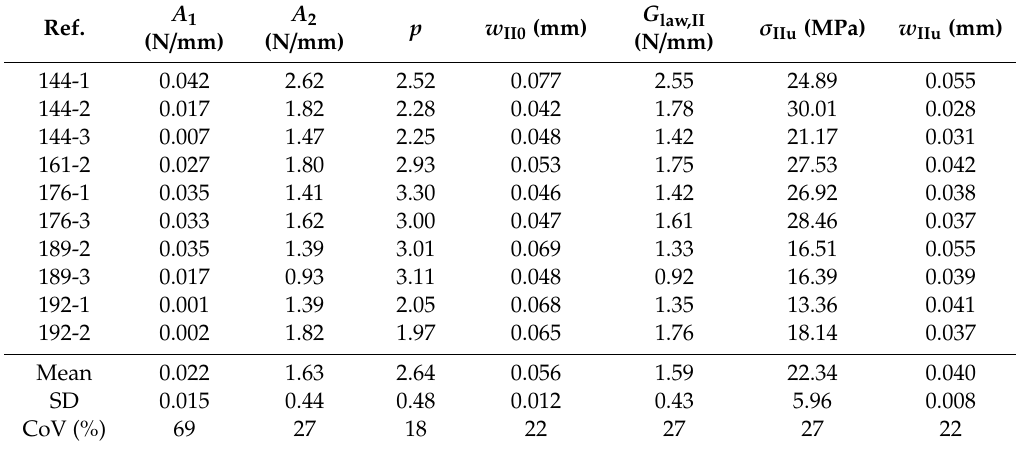
Table 4. Logistic function parameters ( A 1 , A 2 , p and w II0 ), maximum stress ( σ IIu ) and relative displacement ( w IIu ), as determined by CBBM